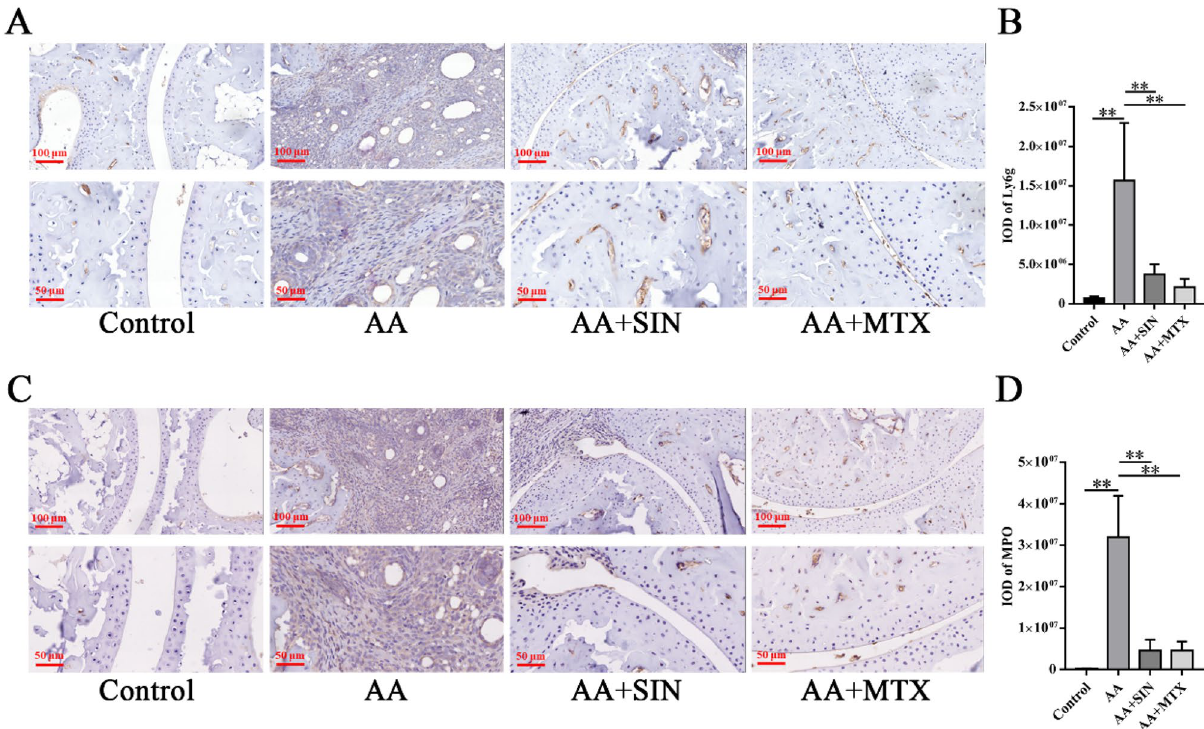
Figure 5. Sinomenine inhibited the migration of neutrophils to local joints. ( A ) IHC assays were performed to measure Ly6G in ankle joint sections. Representative images are shown. ( B ) The IOD of Ly6G in (A). The data are expressed as the mean ± SD (n = 3). ( C ) IHC staining was used to determine the level of MPO in the ankle joint sections from the mice. Representative images are shown. ( D ) The IOD of MPO in ( C ). The data are expressed as the mean ± SD (n = 3). *p < 0.05 , **p < 0.01 . “n = 3” represents three mice with representative joint diameters and arthritis scores that were selected from each group to prepare ankle joint tissue sections, and one representative picture of each mouse was used for